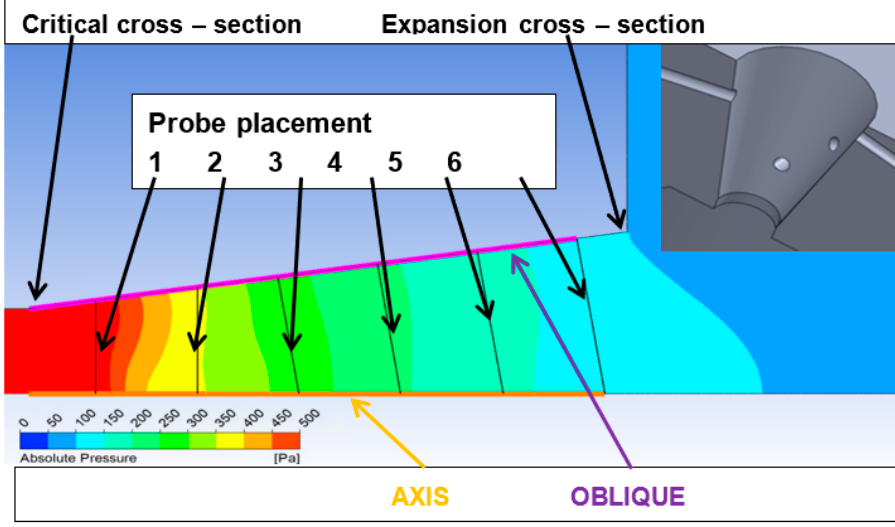
Figure 11. Designed linear nozzle with measuring points for probe placement.